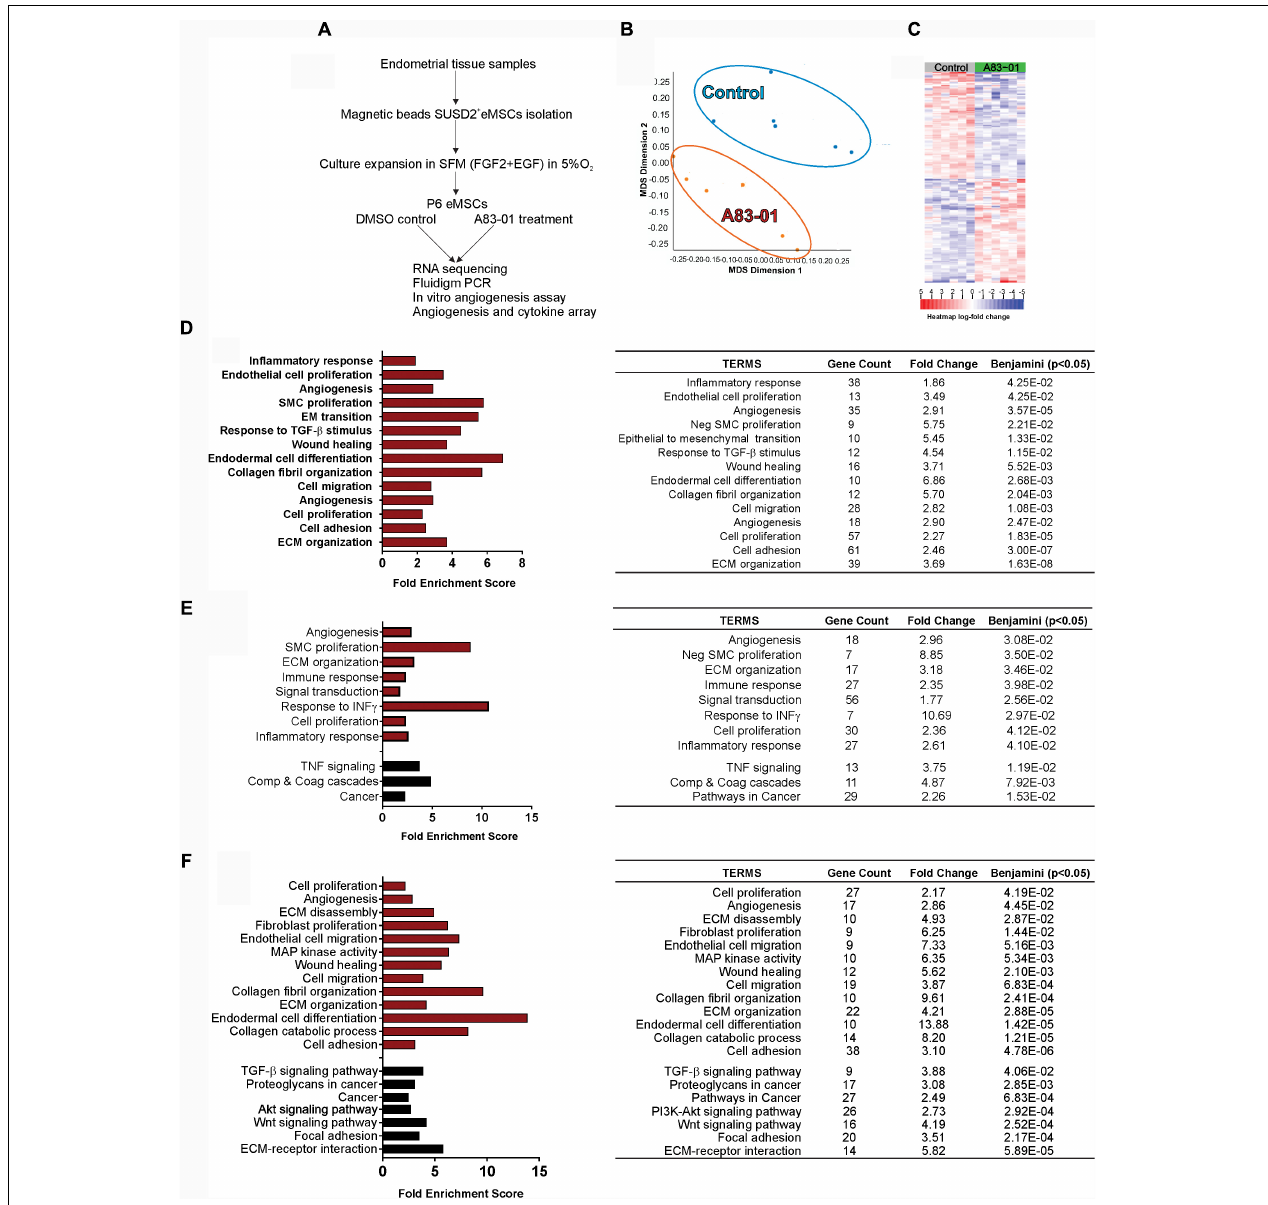
FIGURE 1 | Transcriptome of A83-01 treated P6 eMSCs. (A) Schematic showing study design and experimental steps before RNA sequencing, and subsequent validation and functional assays. (B) Principle Component Analysis demonstrating clear separation of gene transcripts between A83-01-treated and control eMSCs. Each dot represents an experimental replicate. (C) Heat map showing the top 200 up- and down-regulated DEGs with FDR < 0.01 and > 2 fold change ( n = 6). (D) GO analysis of biological processes of all DEGs using DAVID 6.8. A83-01 altered the expression of genes involved in the inflammatory response, angiogenesis, and ECM and collagen fibril organization. (E,F) GO and KEGG analysis of functional annotations and pathways of upregulated (E) and downregulated (F) genes. Red bars (GO) and black bars (KEGG). Fold enrichment change were analyzed by Benjamini–Hochberg ( p < 0.05).